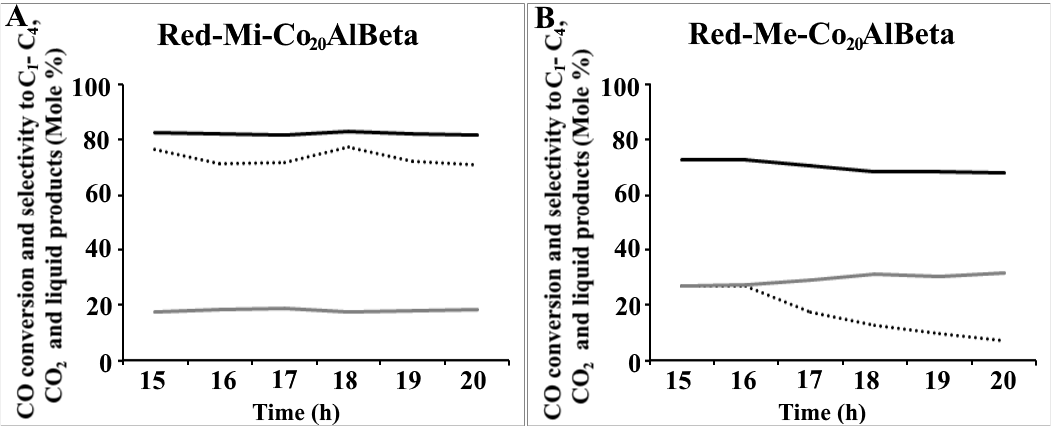
Table 3. The catalytic performance of tested samples after 20 h of reaction.